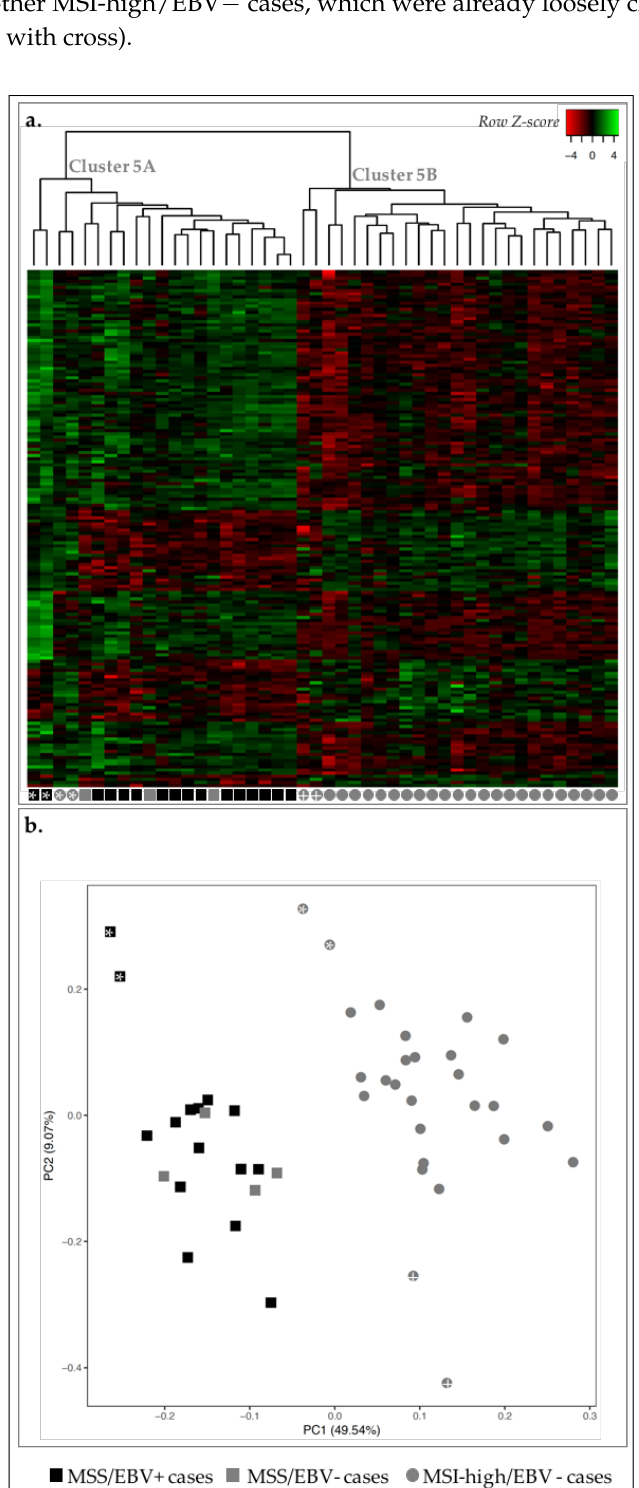
Figure 5. Expression profile of the 46 GC cases for 166 DE-genes between MSS/EBV+ and MSI-high/EBV − cases. ( a ) Heatmap for the expression of the 166 DE-genes (log 2 and Z -score scaled). Indicated are two main clusters: A and B. ( b ) PCA for principal components 1 and 2 for the 46 GC samples. Black squares correspond to MSS/EBV+ cases ( n = 15), gray squares to MSS/EBV − cases ( n = 4) and gray circles to MSI-high/EBV − cases ( n = 27).